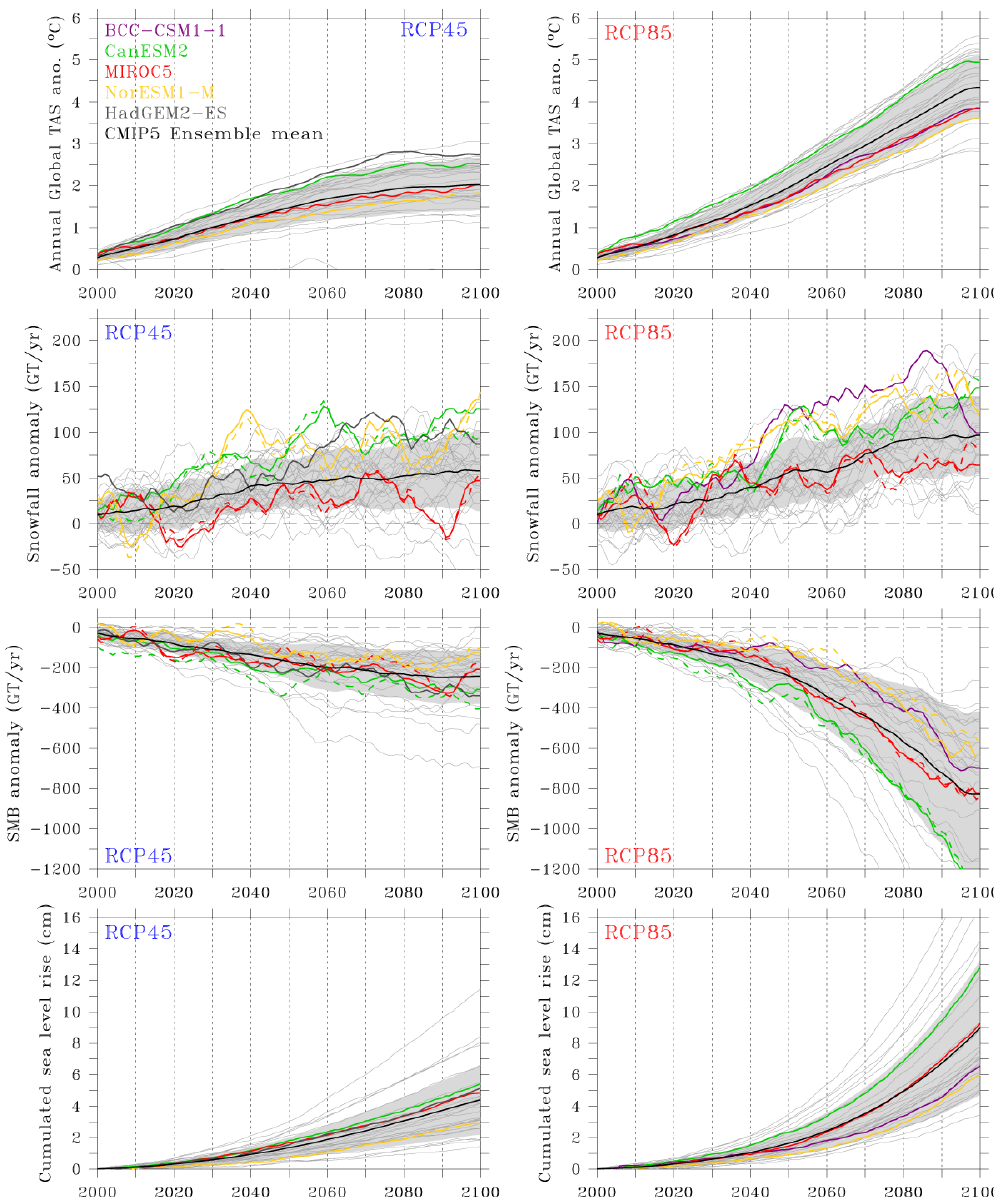
Fig. 7. Same as Fig. 3 but for the annual global TAS (in ◦ C), GrIS snowfall and SMB anomaly in GTyr − 1 according to Eq. (1) as well as the corresponding sea level rise in cm. The dashed coloured lines plot the time series from MAR forced by the corresponding